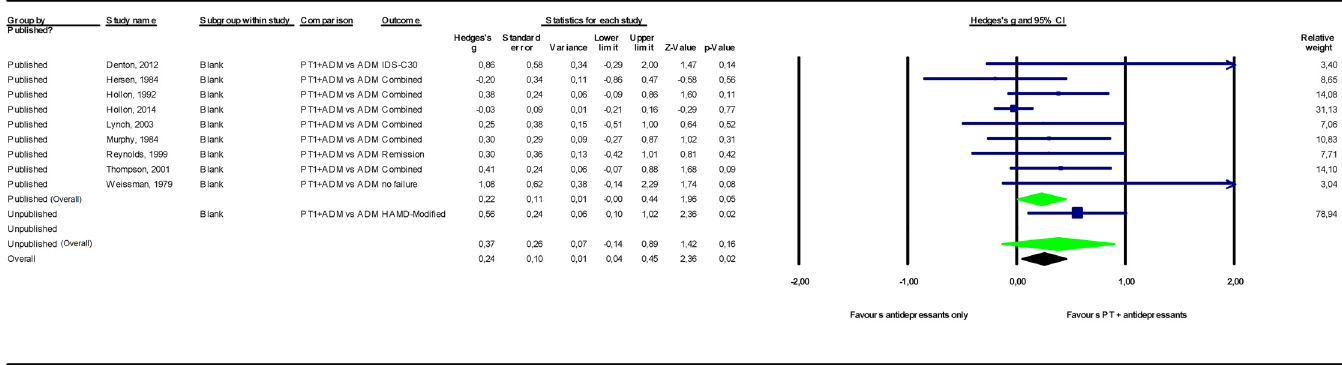
Fig 7. Psychological treatment combined with antidepressant medication versus antidepressant medication monotherapy. Note: Not all results of the unpublished studies are presented at study level, because we did not have permission of the investigators to do so. ADM = antidepressant medication; HAMD = Hamilton Depression Rating Scale; IDS-C30 = Inventory of Depressive Symptomatology – 30-item Clinician Rated version; PT = psychological treatment.